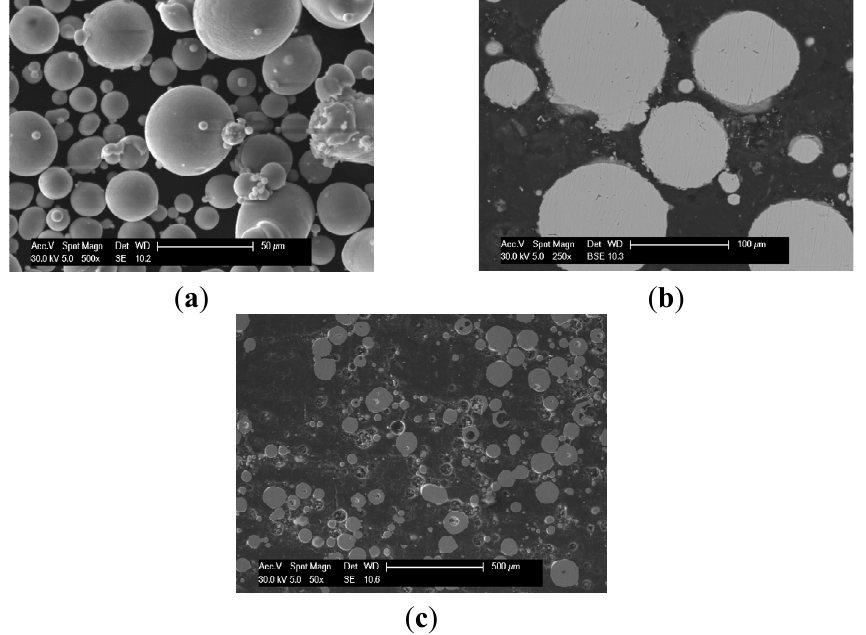
Figure 2. Morphology of the initial gas atomized Fe-40Al (at. %) powder: ( a ) SEM SE image showing spherical particles; ( b ) SEM BSE image of the cross-section of the particles that reveals their chemical homogeneity; and ( c ) voids in the volume of the